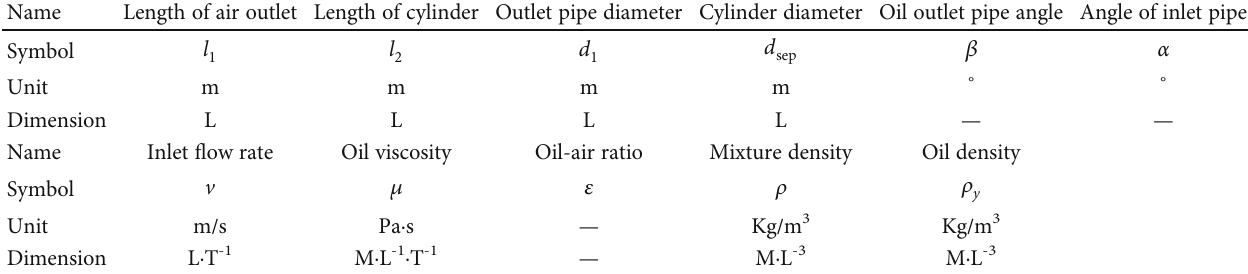
Table 2: Main in fl uence parameters and